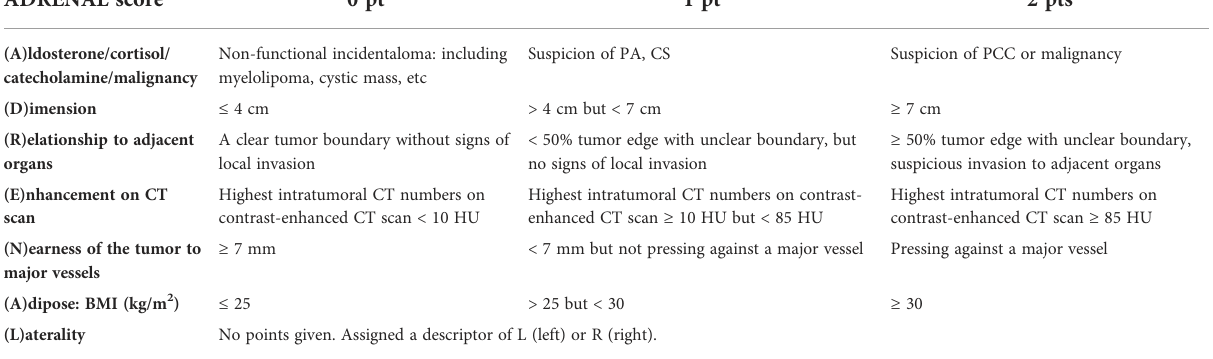
TABLE 2 Components and criteria of the ADRENAL